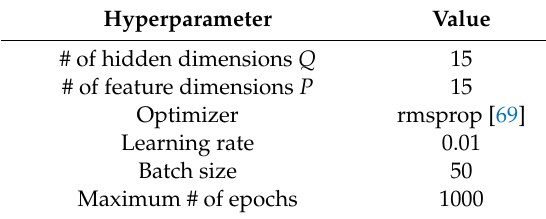
Table 12. Hyperparameters used for the disturbance classification